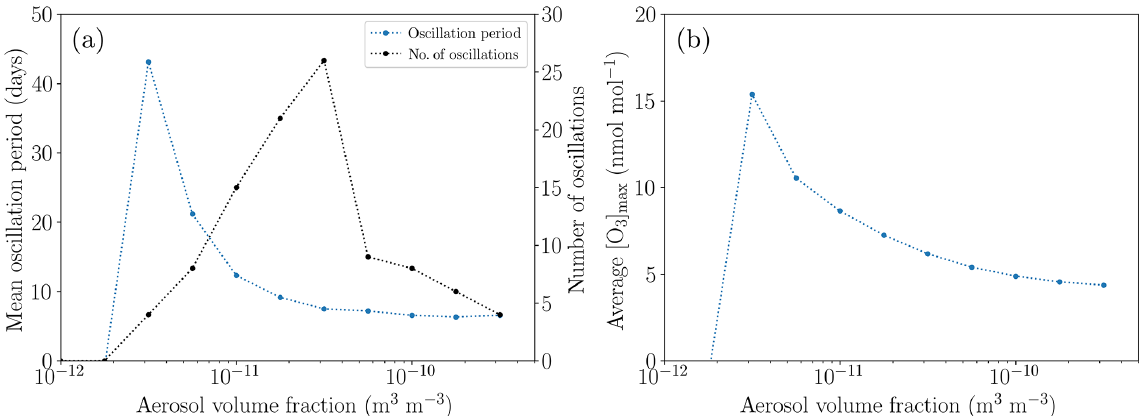
Figure 12. Oscillation characteristics depending on the aerosol volume fraction after 200d. (a) Mean oscillation period. (b) Average maxi- mum ozone mixing ratio.